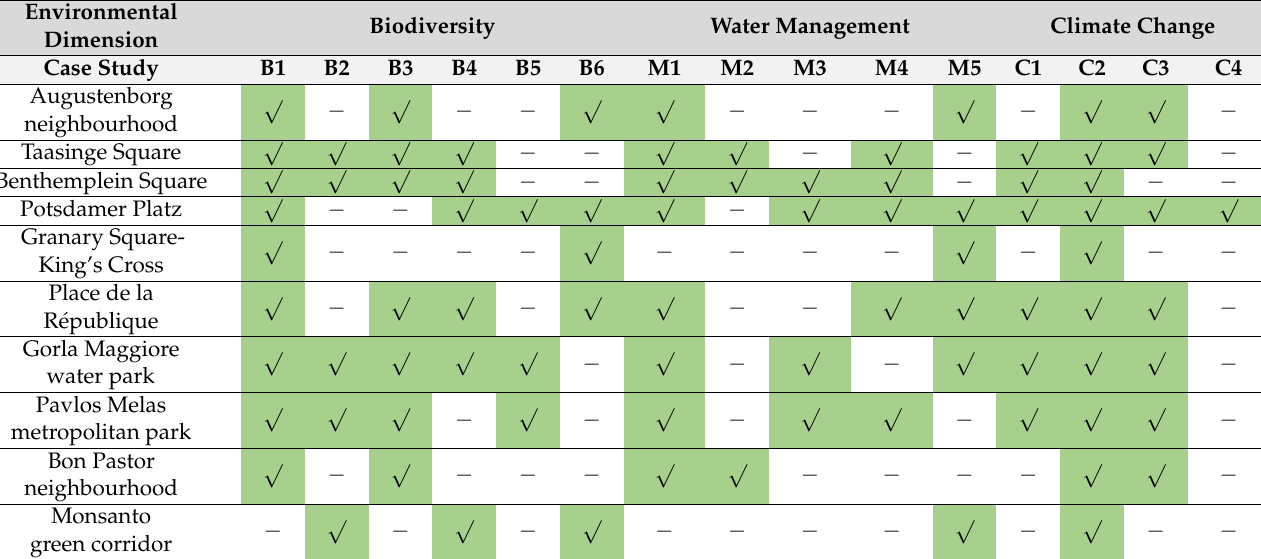
Table 5. The environmental dimension in case